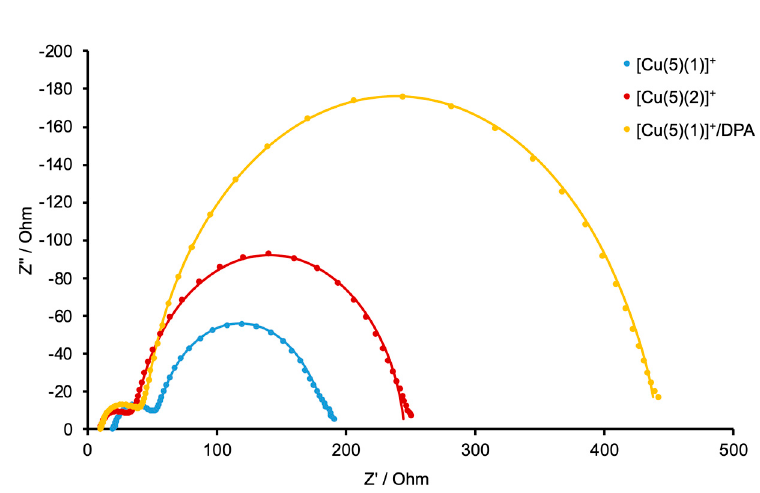
Figure 14. Equivalent circuit used to fit the electrochemical impedance spectroscopy (EIS) data, where R s is the series resistance, R Pt and CPE1 are the resistance and constant phase element of the platinum counter electrode, DX1 is an extended distributed element that represents the TiO 2 / electrolyte interface and W S is the Warburg element associated with di ff usion of the electrolyte.